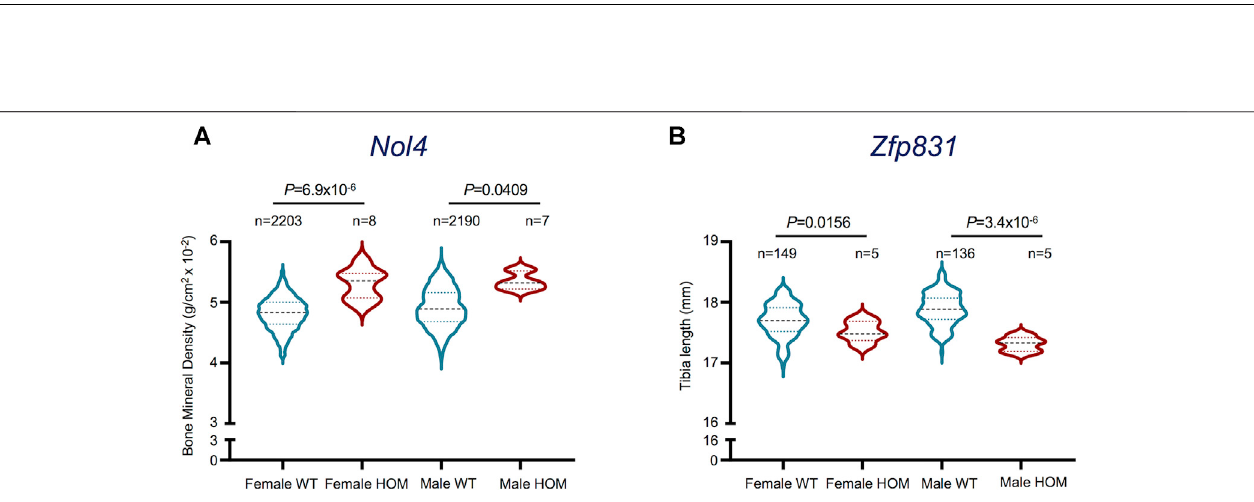
FIGURE 5 | Bone-related phenotypes of Nol4 and Zfp831 knockout mice in the International Mouse Phenotyping (IMPC) datasets. (A) Violin plot shows the differencesinBoneMineralDensity(excludingskull)infemale(n (cid:2) 8),male(n (cid:2) 7)homozygote(HOM)mutantsforthe Nol4 em1(IMPC)J allelecomparedtofemale(n (cid:2) 2,203), male (n (cid:2) 2,190) wild type (WT) controls. (B) Violin plot shows the differences in Tibia length in female (n (cid:2) 5), male (n (cid:2) 5) HOM mutants for Zfp831 tm1b(KOMP)Wtsi allele comparedtofemale(n (cid:2) 149)andmalecontrols(n (cid:2) 136).Theinterquartilerange,minimumandmaximumdatapoints,andindividualpointsrepresentingoutliersof each datasetare presented. p values represent thestatisticalsigni fi cance between each comparison [Data takenfrom theInternational Mouse Phenotyping Consortium (IMPC) (Dickinson et al., 2016; International Mouse Phenotyping Consortium, 2021)].